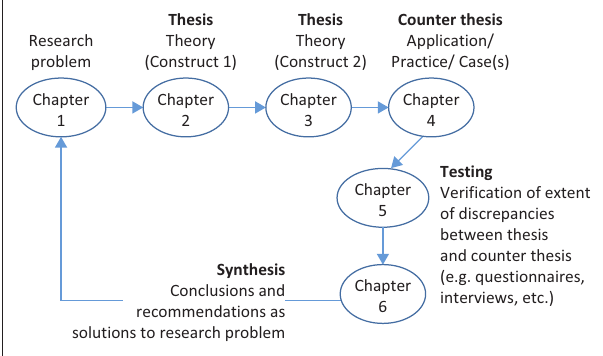
FIGURE 2: Theory in mixed-method applied social science research